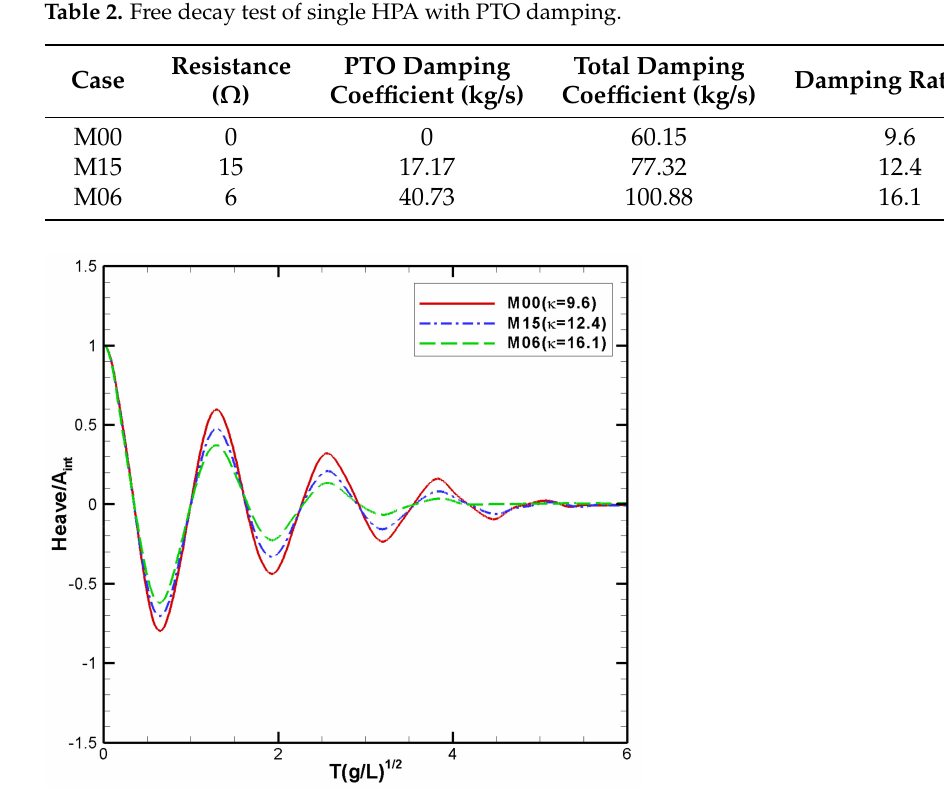
Figure 7. Free decay test of single HPA with different PTO damping coefficients. Even in the absence of a resistor, a damping ratio ( κ ) of 9.6 occurs in M00, which can be regarded as radiation, mechanical, and viscous damping. The damping coefficient can be obtained using b = 2 κρ gS / ω N . The PTO damping coefficients, b PTO , for M15 and M06 were calculated by subtracting the M00 results from M15 and M06. The PTO damping coefficients for M15 and M06 were found to be 17.17 and 40.73 kg/s, respectively. Notably, when the load resistance is connected to 6 Ω , the PTO damping coefficient is very close to the theoretically calculated optimal PTO damping coefficient (38